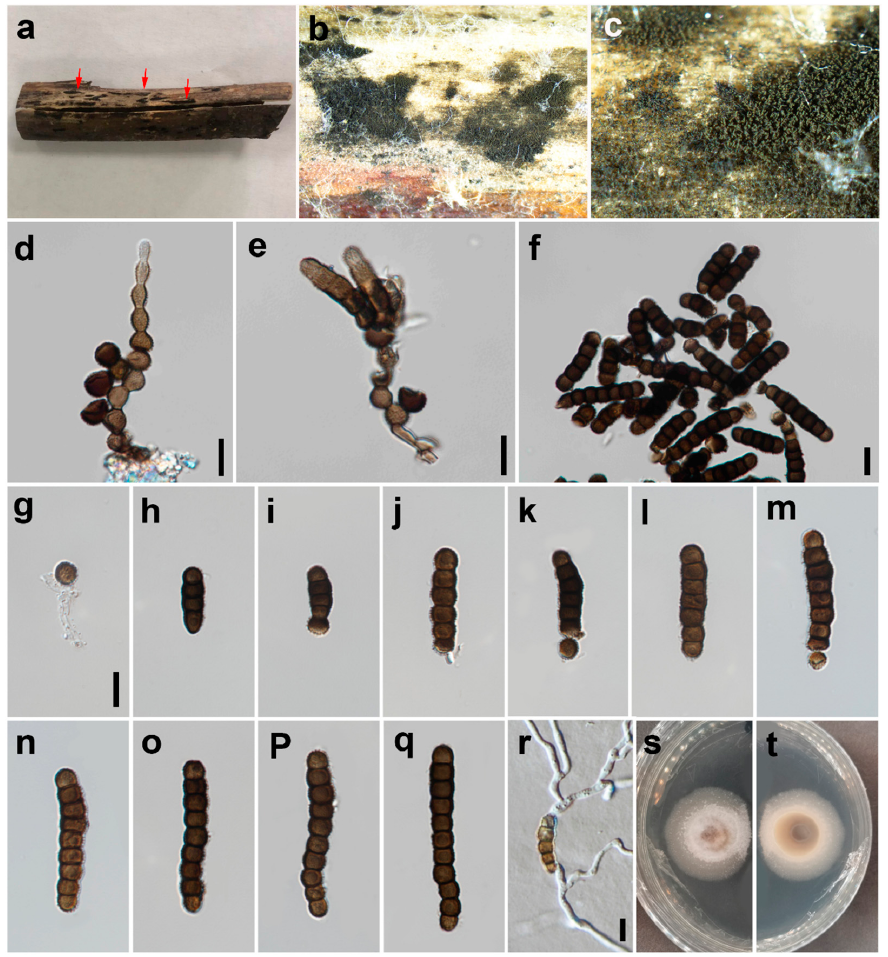
Figure 5. Torula sichuanensis (HKAS 126511, holotype). ( a – c ) Colonies on the natural substrate; arrows indicate the locations of colonies. ( d , e ) Conidiophores, conidiogenous cells and conidia. ( f ) Squash mount of partial colony. ( g – q ) Conidia; ( r ) Germinated conidium; ( s , t ) Culture on PDA from surface and reverse. Scale bars: ( d – r ) = 10 µm. Scale bar of g applies to g – q .